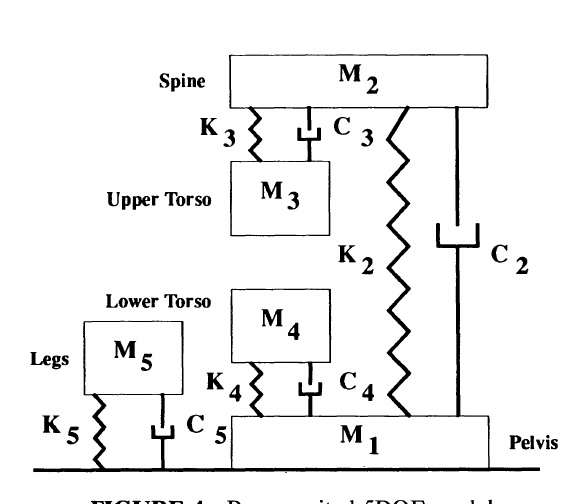
FIGURE 4 Base-excited 5DOF